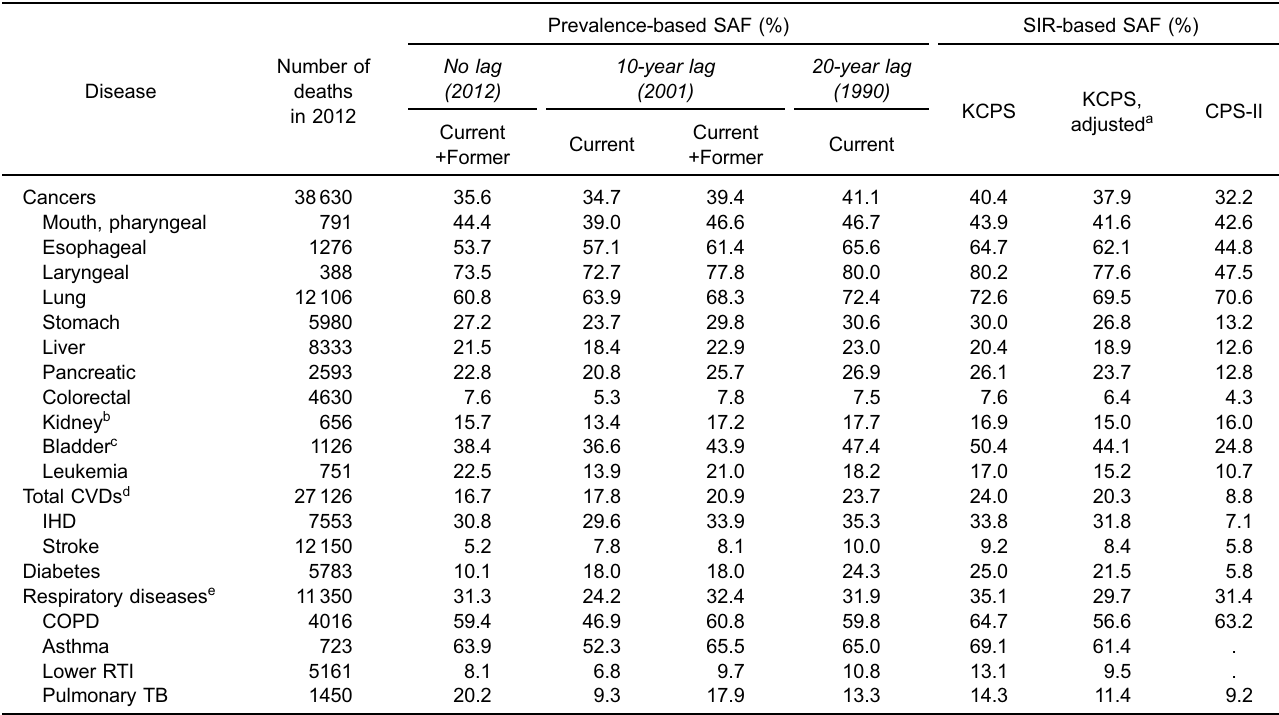
Table 3. Estimated smoking-attributable fraction of deaths among Korean males in 2012 calculated using smoking impact ratio- and prevalence-based methods